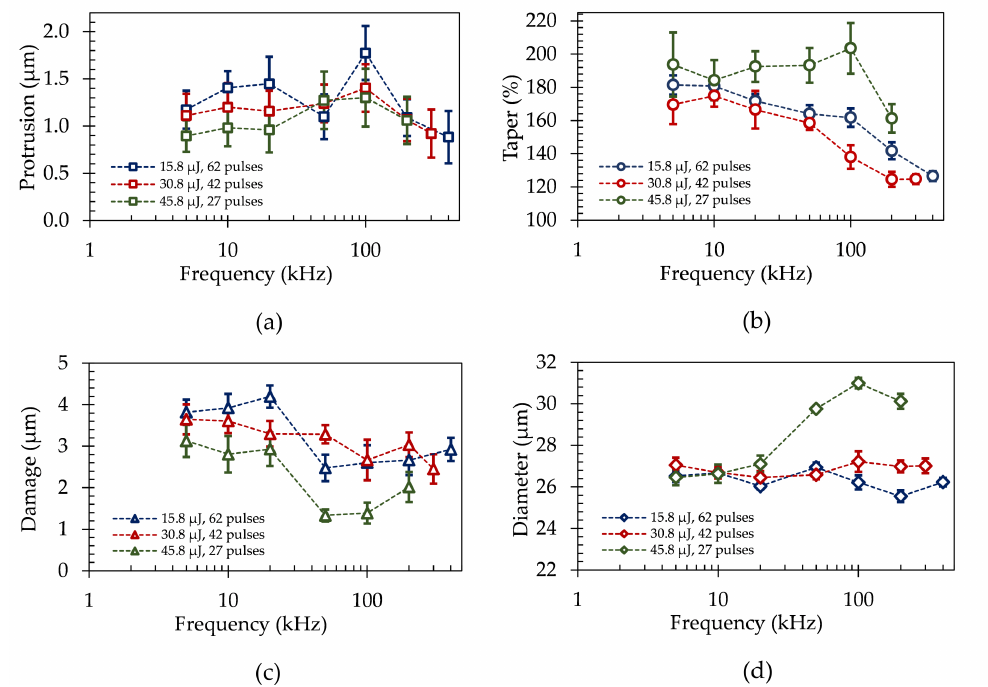
Figure 6. ( a ) Glass fiber protrusion, ( b ) taper, ( c ) damage in inner copper layer, and ( d ) diameter of 10 laser drilled microvias depending on the laser pulse energy of E = 15.8–45.8 µJ and laser pulse repetition rate of f = 5–400 kHz using a laser pulse duration of τ = 2